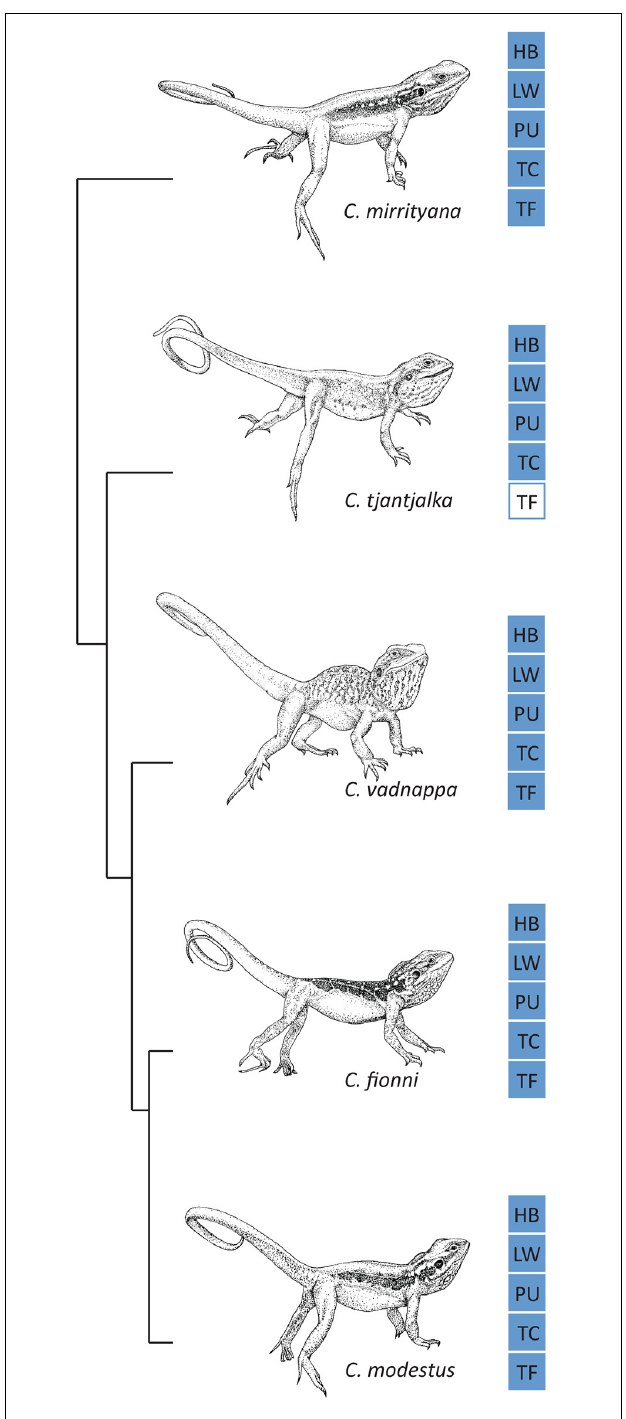
FIGURE 1 | The five species in the Ctenophorus decresii complex included in this study. Ctenophorus decresii is absent due to the recent elevation of its two divergent lineages to distinct species: C. decresii and C. modestus (Dong et al., 2021). Phylogeny is shown on the left (adapted from McLean et al., 2013, with C. modestus as C. decresii ) and core motor patterns are shown for each species on the right: HB, head bobs; LW, limb waves; PU, push ups; TC, tail coil; TF, tail flick. Blue squares represent known motor patterns, and white squares represent motor patterns that have not been reported.